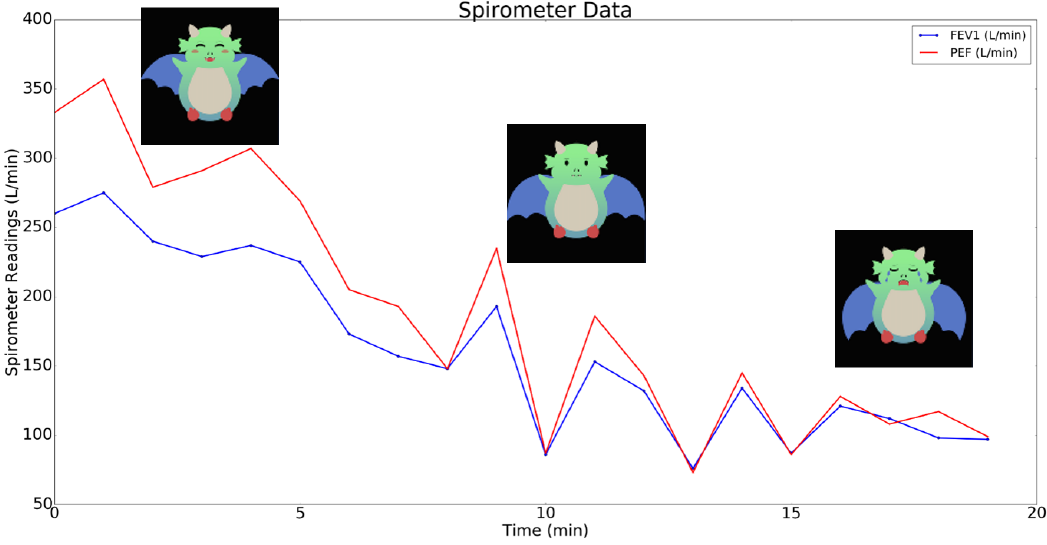
Figure 5. PEF and FEV1 spirometer readings and corresponding asthma risk labels when the adult individual entered a smoky